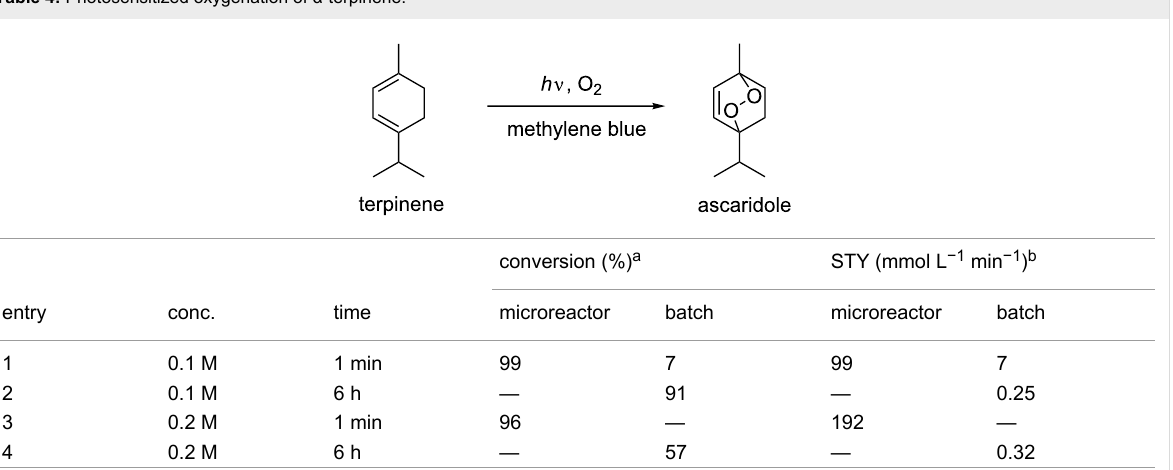
Table 4: Photosensitized oxygenation of α